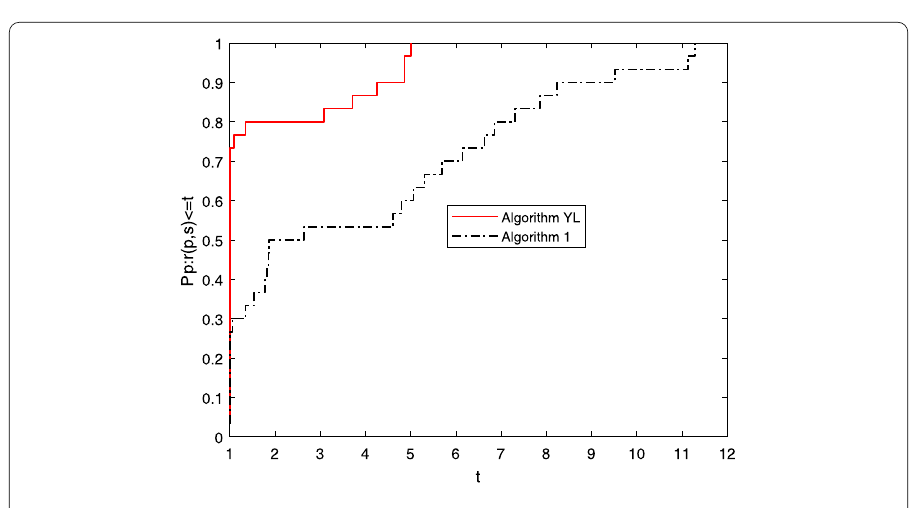
Figure 3 Performance profiles of these methods